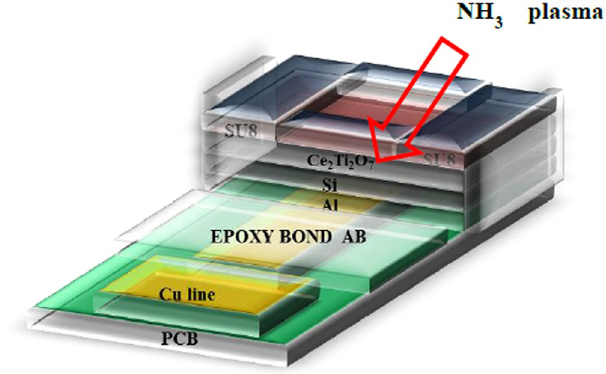
Figure 1. The Ce 2 Ti 2 O 7 EIS structure.